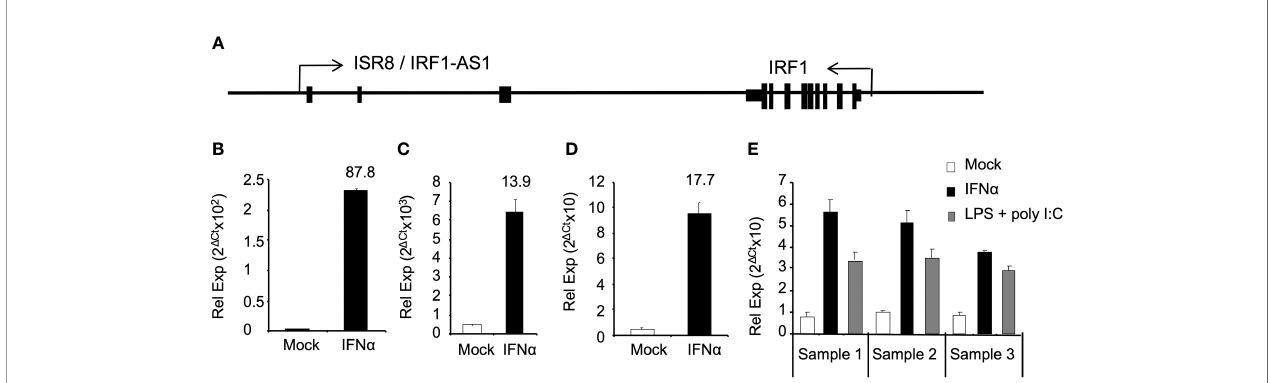
FIGURE 1 | ISR8/IRF1-AS1 is induced by IFN a in different cell lines. (A) Schematic of ISR8/IRF1-AS1 and IRF1 coding gene. (B – E) . HUH7 (B) and HeLa (C) cells, macrophages (D) and PBMCs (E) were treated with none or 1000 U/ml IFN a for 6h. PBMCs were also treated with 5 µg/ml LPS plus 15 µg/µl poly (I:C) for 6 h (E) . ISR8 expression levels were measured by RT-qPCR. GAPDH mRNA was also evaluated and used as a reference. Error bars indicate standard deviations. Fold increase is indicated at the top of each bar. Experiments were performed at least twice and a representative fi gure is